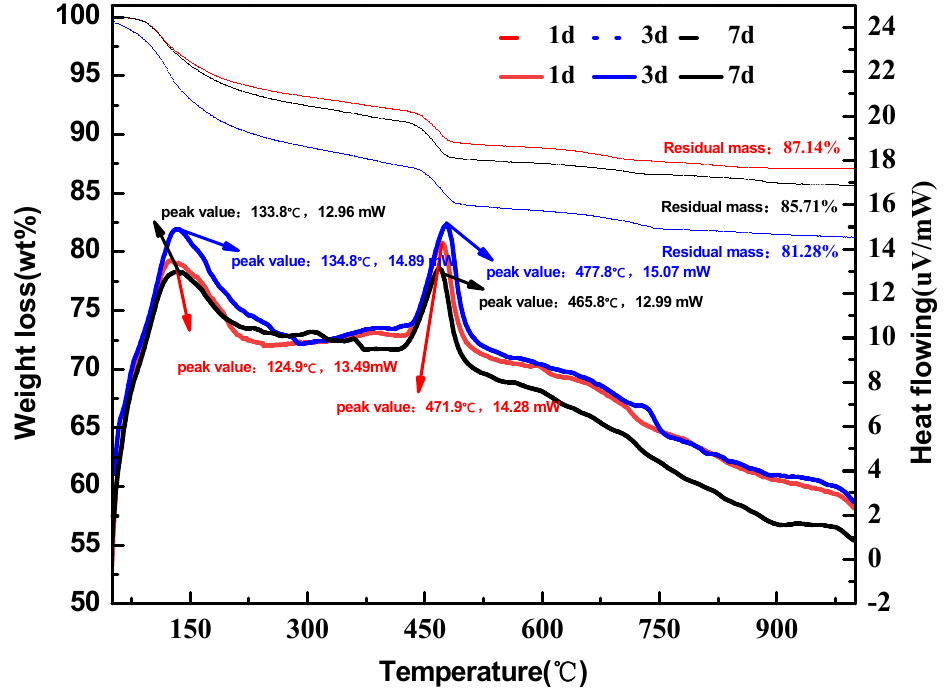
Figure 6. The ESEM-EDS images of the BBSC paste. Table 6. The elemental structure of the cement paste.